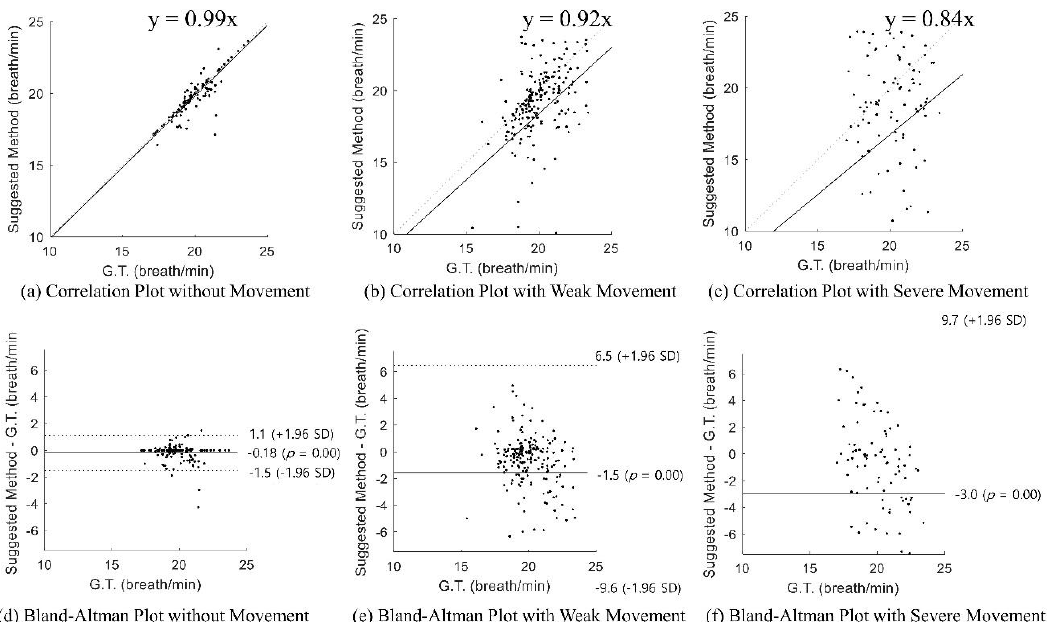
Figure 9. Statistical evaluation of the respiration rate detection over long periods: ( a ) correlation plot without movement, ( b ) correlation plot with weak movement, ( c ) correlation plot with severe movement, ( d ) Bland–Altman plot without movement, ( e ) Bland–Altman plot with weak movement, and ( f ) Bland–Altman plot with severe movement.